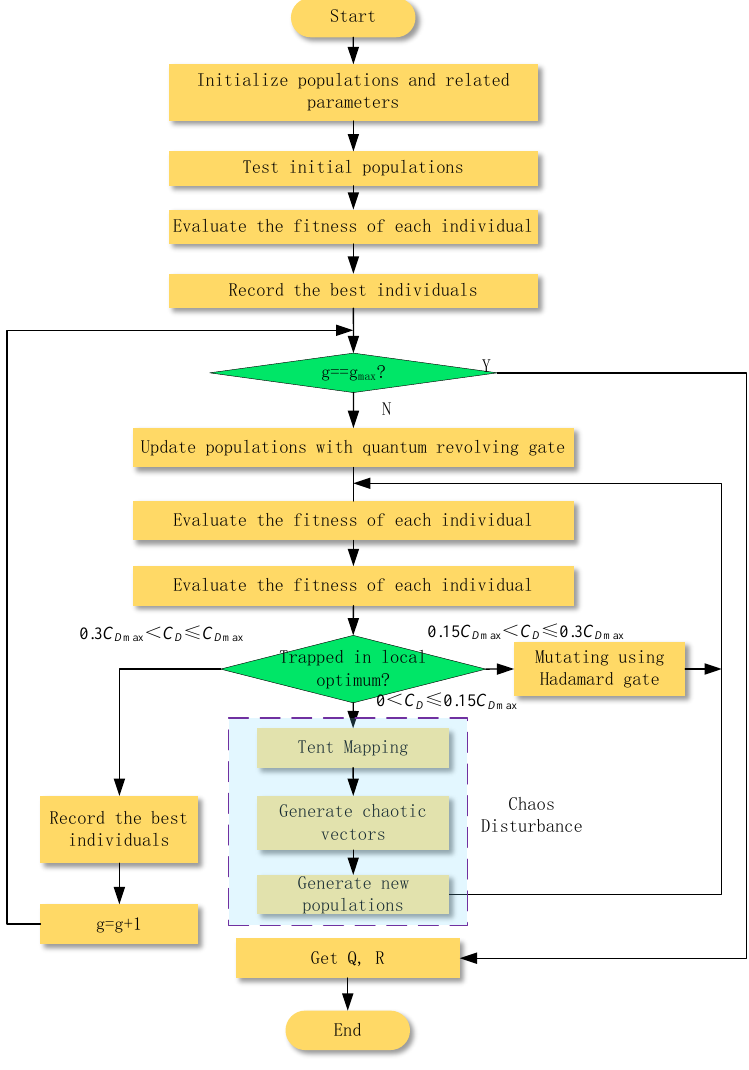
Figure 3. Flow chart of IQGA.